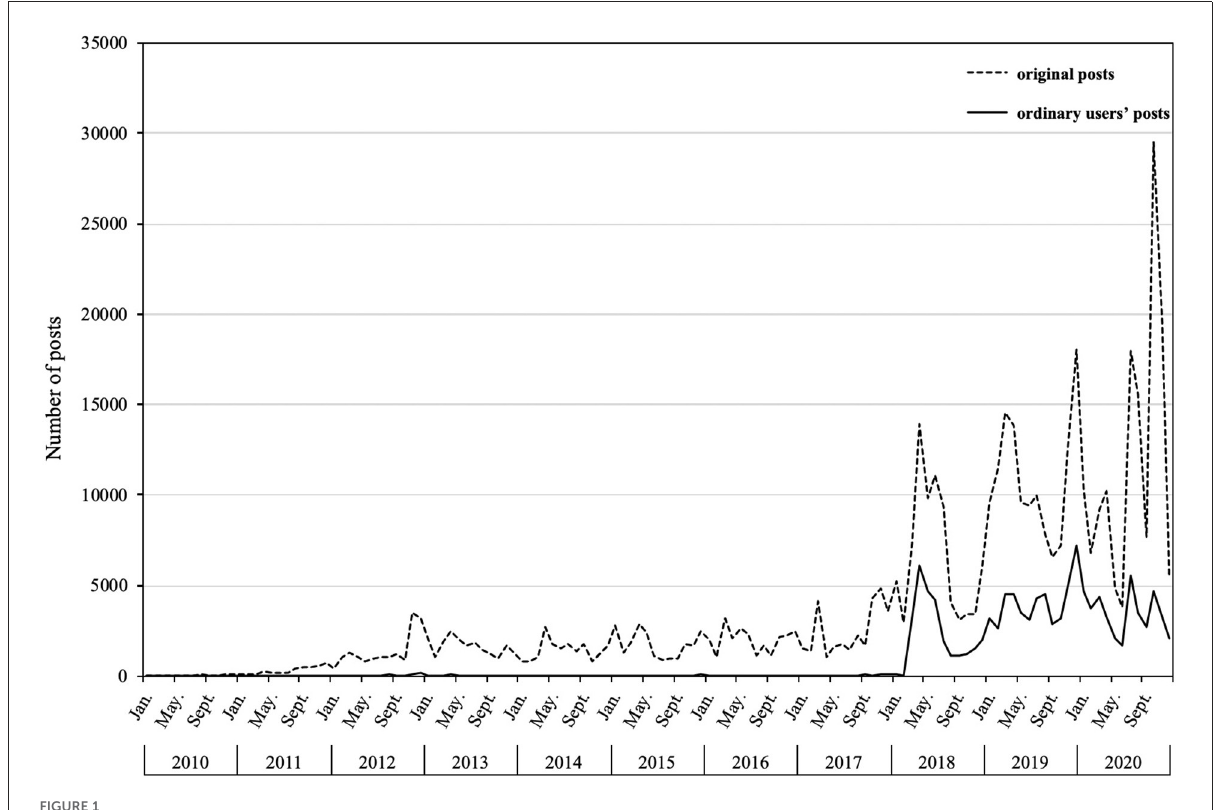
FIGURE1 Distribution of the number of original and ordinary users’ posts over